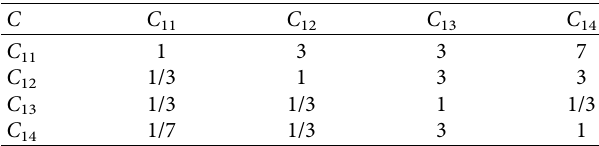
Table 18: C – C 1-4 judgment matrix.